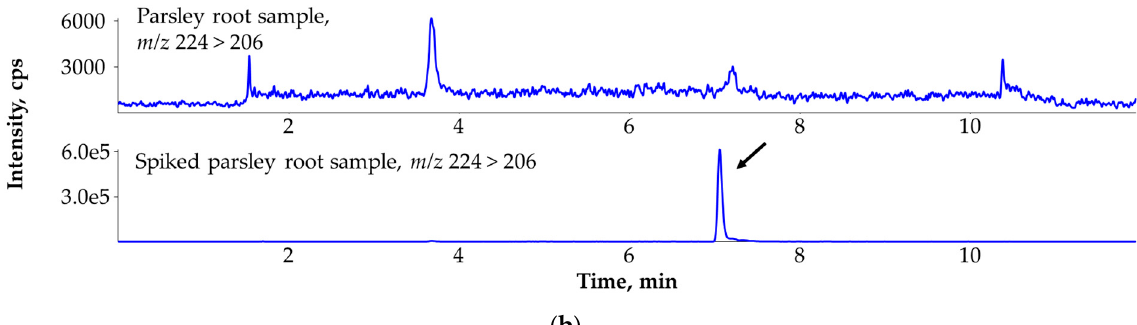
Figure 7. ( a ) Screening analysis of parsley root sample. The ion transitions of mepanipyrim in a neat solvent calibrant (100 ng/mL, above) and in the sample (below). ( b ) Confirmatory analysis of parsley root sample for mepanipyrim using standard addition. The 224 > 206 ion transition (Rt = 7.10 min) was selective enough to exclude the presence of the analyte in the sample. This ion trace appeared only in the chromatogram of the spiked sample (0.050 mg/kg, below). The arrow shows the appearance of signal in the expected retention time in the fortified sample due to the spiking.